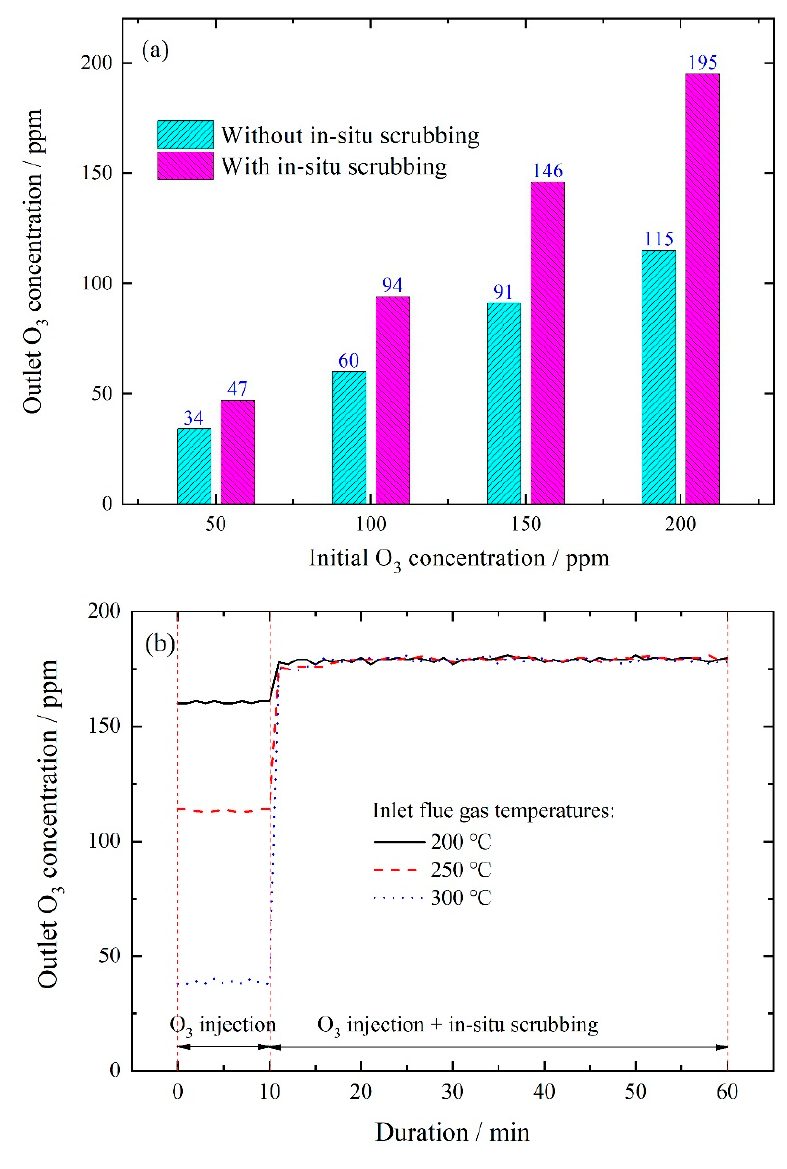
Figure 6. The effects of wet scrubbing on outlet O 3 concentrations: ( a ) various initial ozone concentrations with inlet flue gas temperature of 250 °C and ( b ) various inlet flue gas temperatures with initial ozone concentration of 200 ppm.